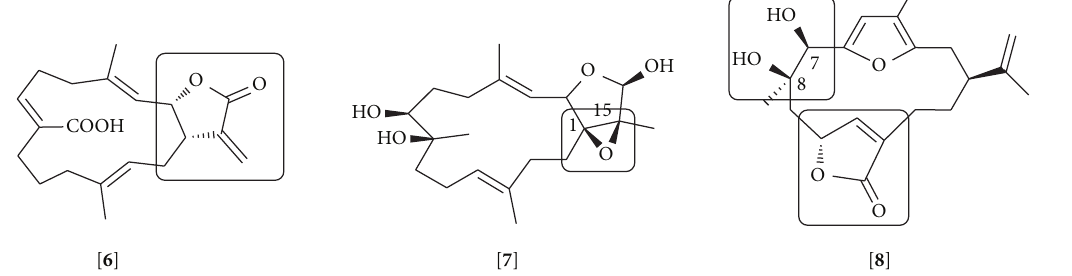
Figure 4: Cembrane diterpenoids: lobohedleolide [ 6 ], lobocrasol A [ 7 ], and sinumaximol B [ 8 ]. The presence of a 𝛼 -methylene- 𝛾 -lactone in lobohedleolide (and cembranolides); an epoxy group at C-1/C-15 in lobocrasol A and a hydroxyl group at C-7 and/or C-8 in sinumaximol B are